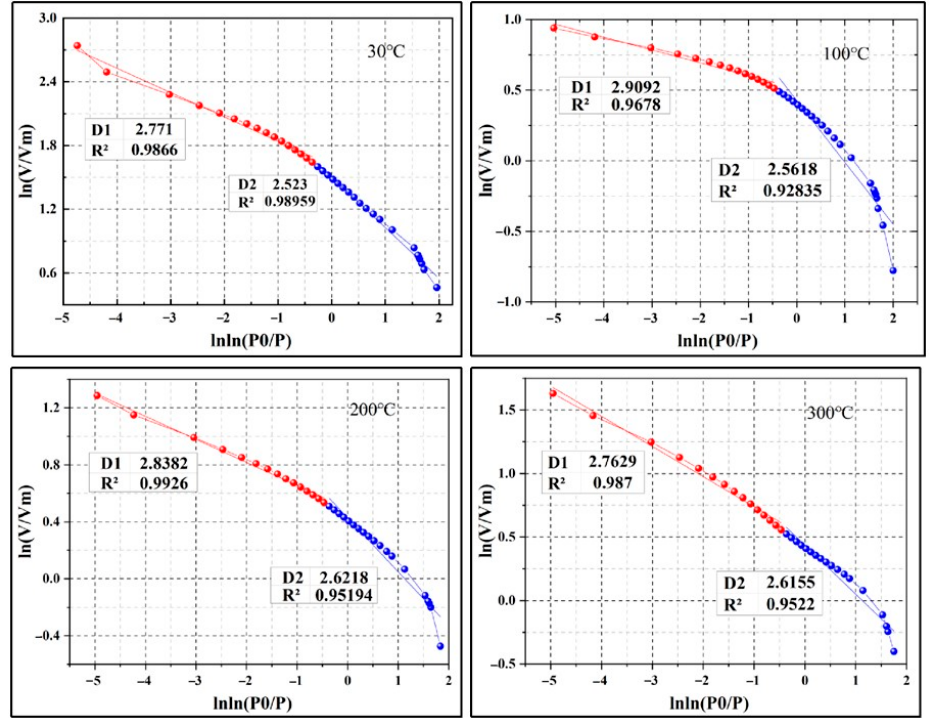
Figure 8. The average frequency of the main frequency of coal under different temperature condi- tions.